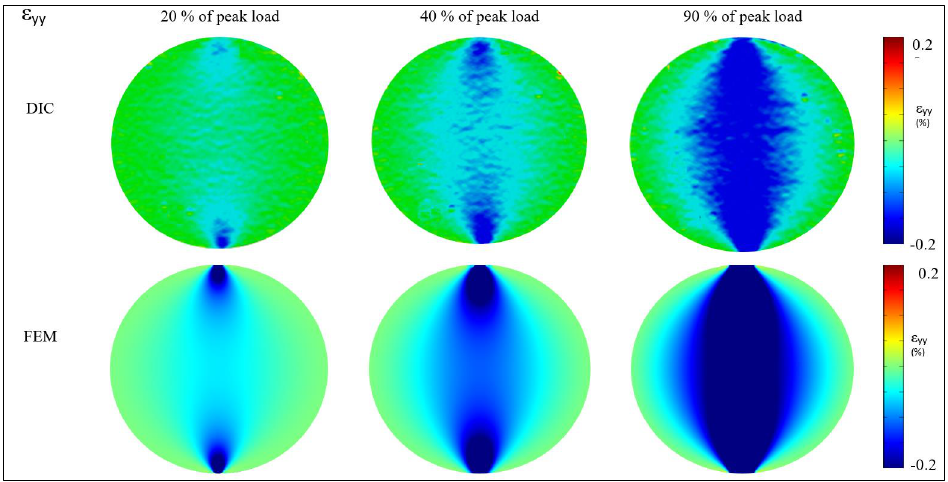
Figure 9. Vertical strain ( ε yy ) distribution: DIC vs. simulation results.